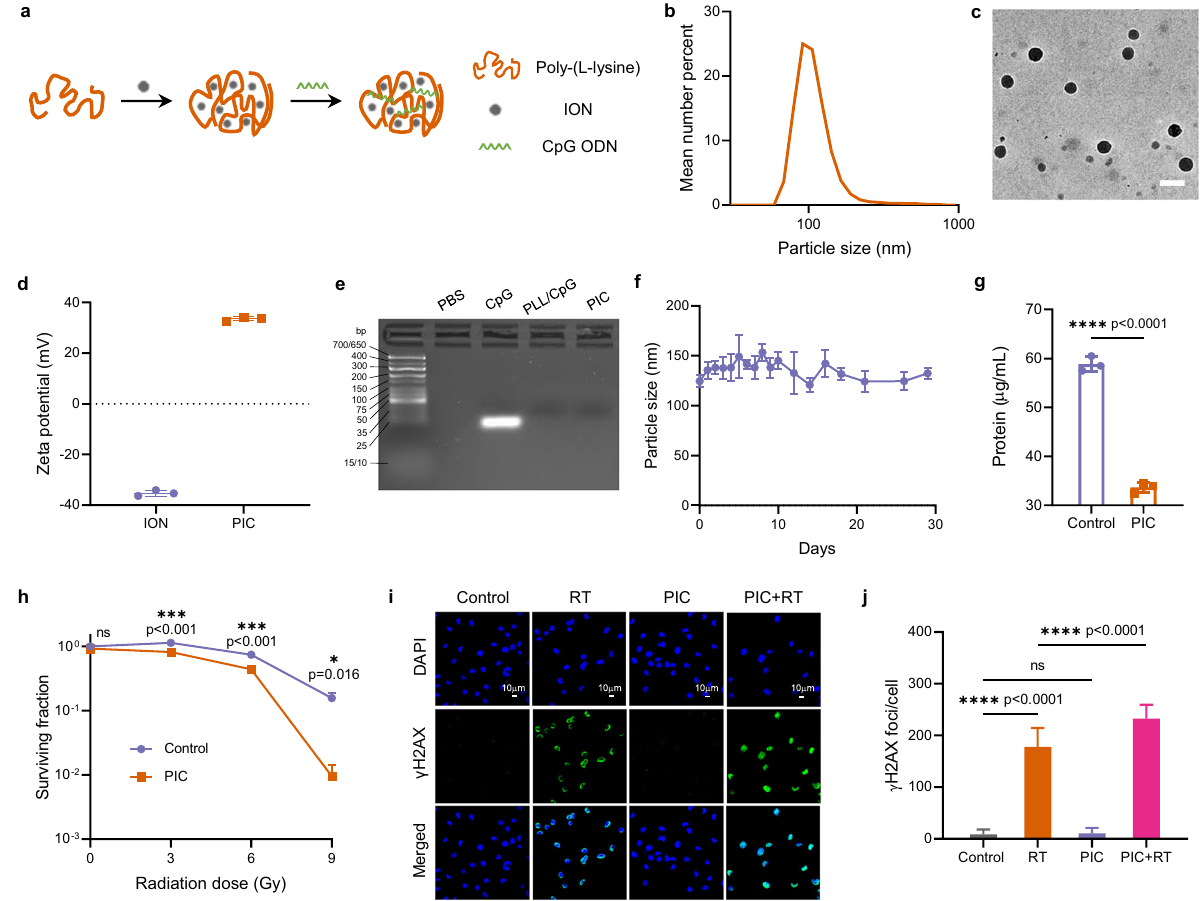
Fig.1|PreparationandcharacterizationofPIC.a ThepreparationprocessofPIC. b Hydrodynamic size distribution of PIC. c Transmission electron microscopy image of PIC. Scale bar: 100nm. d Zeta potentials of ION and PIC. ( n =3 indepen- dentsamples). e CpGcomplexationabilitiesindifferentformulations,asmeasured by agarose gel electrophoresis. f The particle size stability of PIC during storage at 4°C. ( n =3 independent samples). g The protein concentrations in B78 cell lysates after incubation with PIC (0.14mg/mL) for 4h. ( n =3 biologically independent samples). h Clonogenic assay of B78 melanoma cells after treatment with PIC (4.67 μ g/mL) and indicated radiation doses. ( n =3 biologically independent sam- ples). PIC was added to the cells 4h before radiation, and fresh culture media was exchanged for this PIC treatment media 1h after radiation. The colonies were